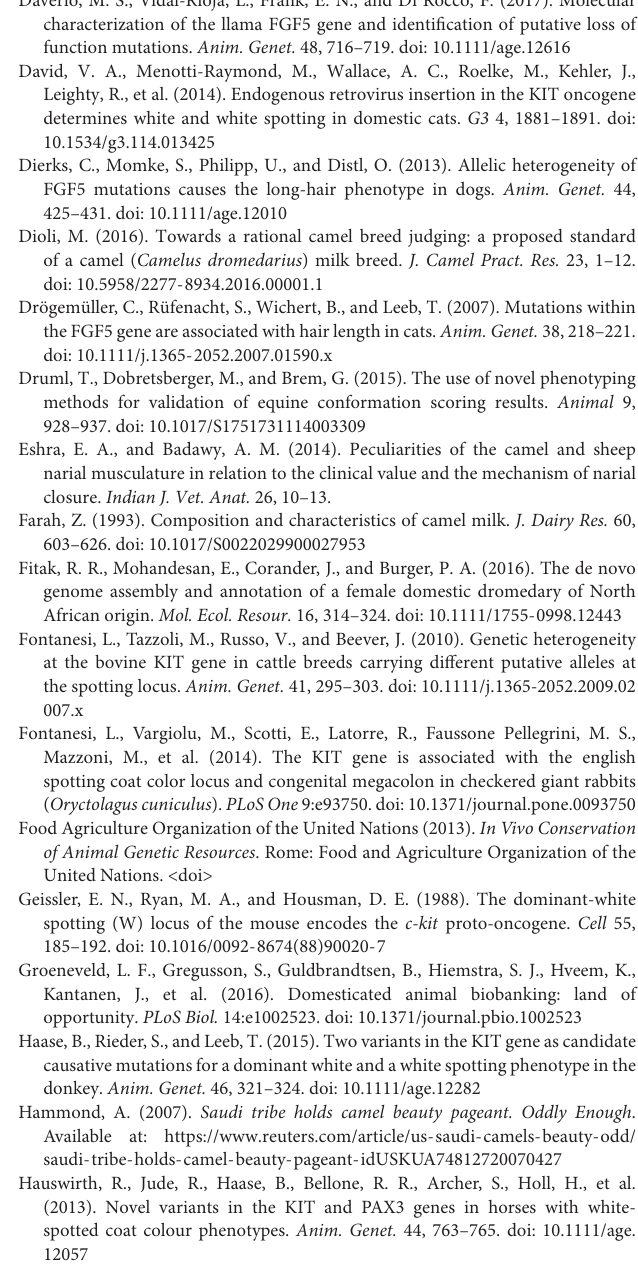
TABLE S2 | Names of “Mezayen” camel breeds and their subtypes. Names of breeds and subtypes were translated from original Arabic terms and the Arabic pronunciation shown in italics. The translations are near exact to what is offered by the breeders, and in some cases the names do not exactly reflect the actual appearance. For visual comparison refer to Figure 6 . TABLE S3 | Terminology of Mezayen camel coat texture and ear shape. Phenotype terminologies were translated from original Arabic terms and the Arabic pronunciation shown in italics. TABLE S4 | Current sample list and information of the Cdrom